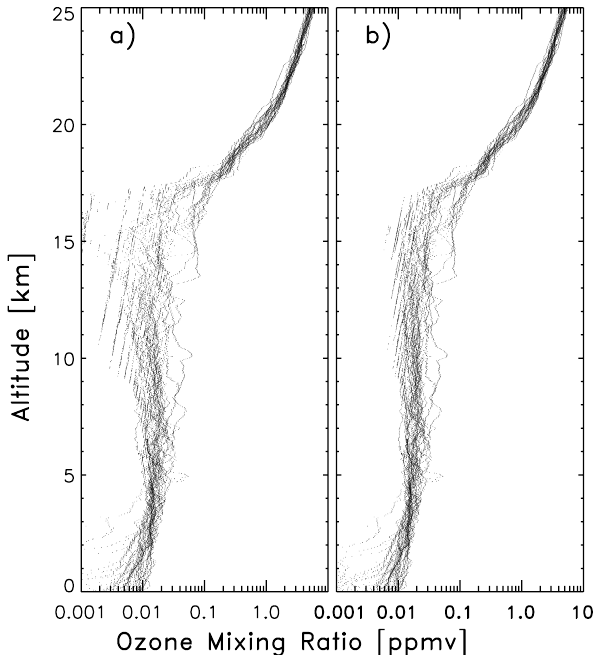
Fig. 5. (a) CEPEX ozone profiles using original background value; (b) reprocessed CEPEX ozone